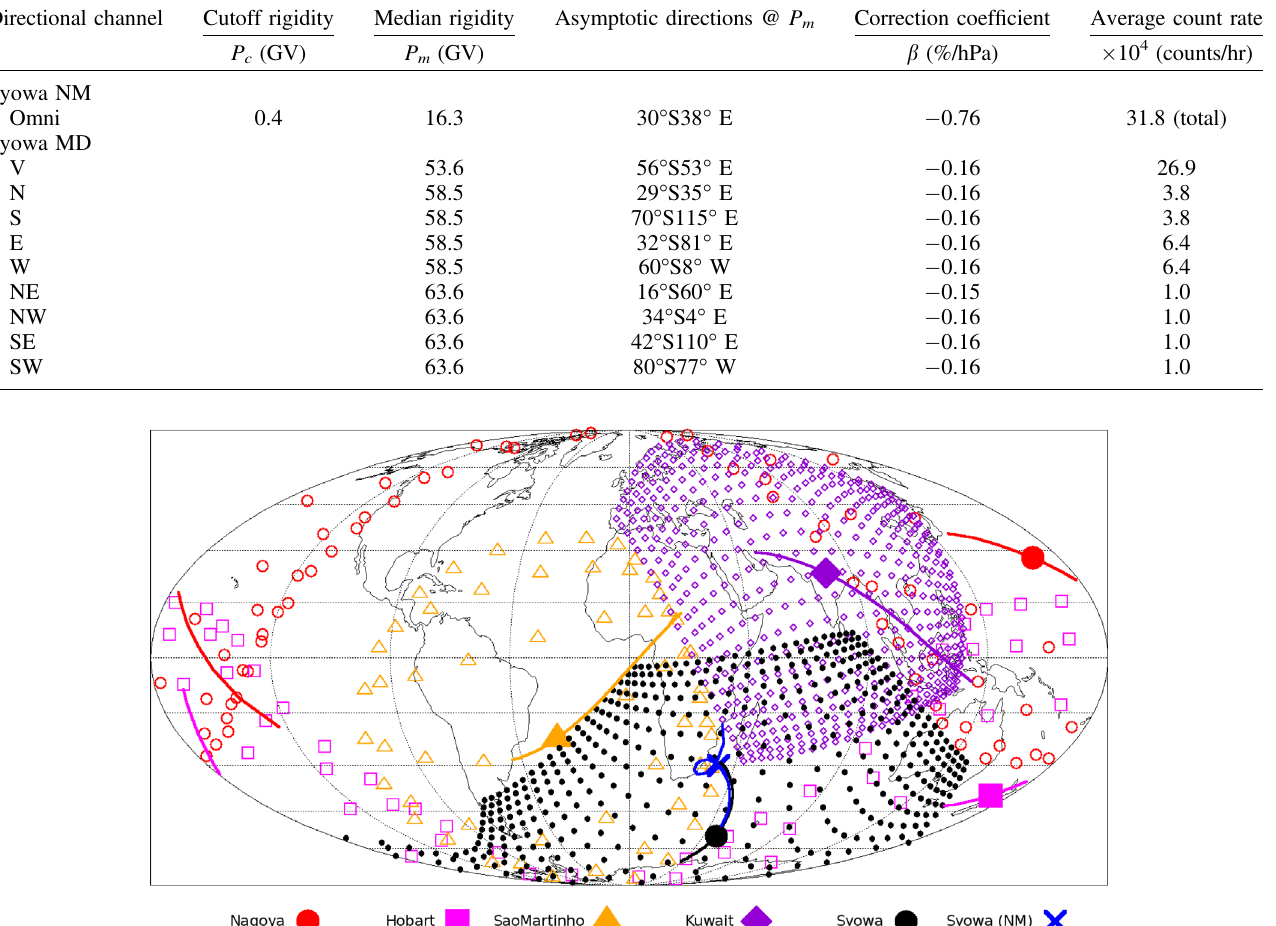
Fig. 6. Asymptotic viewing directions of the GMDN and MD + NM at Syowa Station. Each small symbol shows the asymptotic direction of primary GCR having the median primary rigidity ( P m ) observed in each directional channel of GMDN and Syowa MD. Each large solid symbol indicates the viewing direction of the vertical channel in each MD, while a large cross symbol indicates a viewing direction of Syowa NM. The track through each solid symbol represents the spread of viewing directions corresponding to the central 80% of the rigidity response.